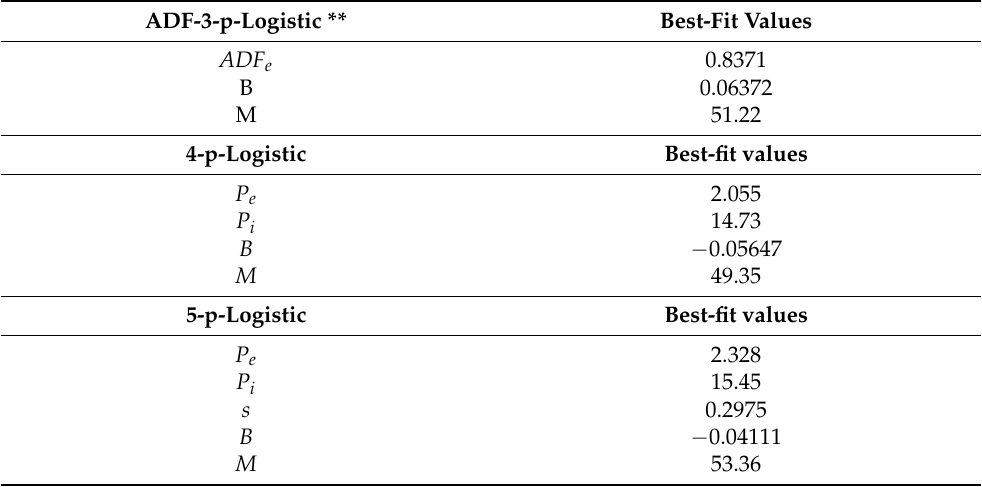
Table 2. Statistical evaluation of the curve fit of the Australian lager